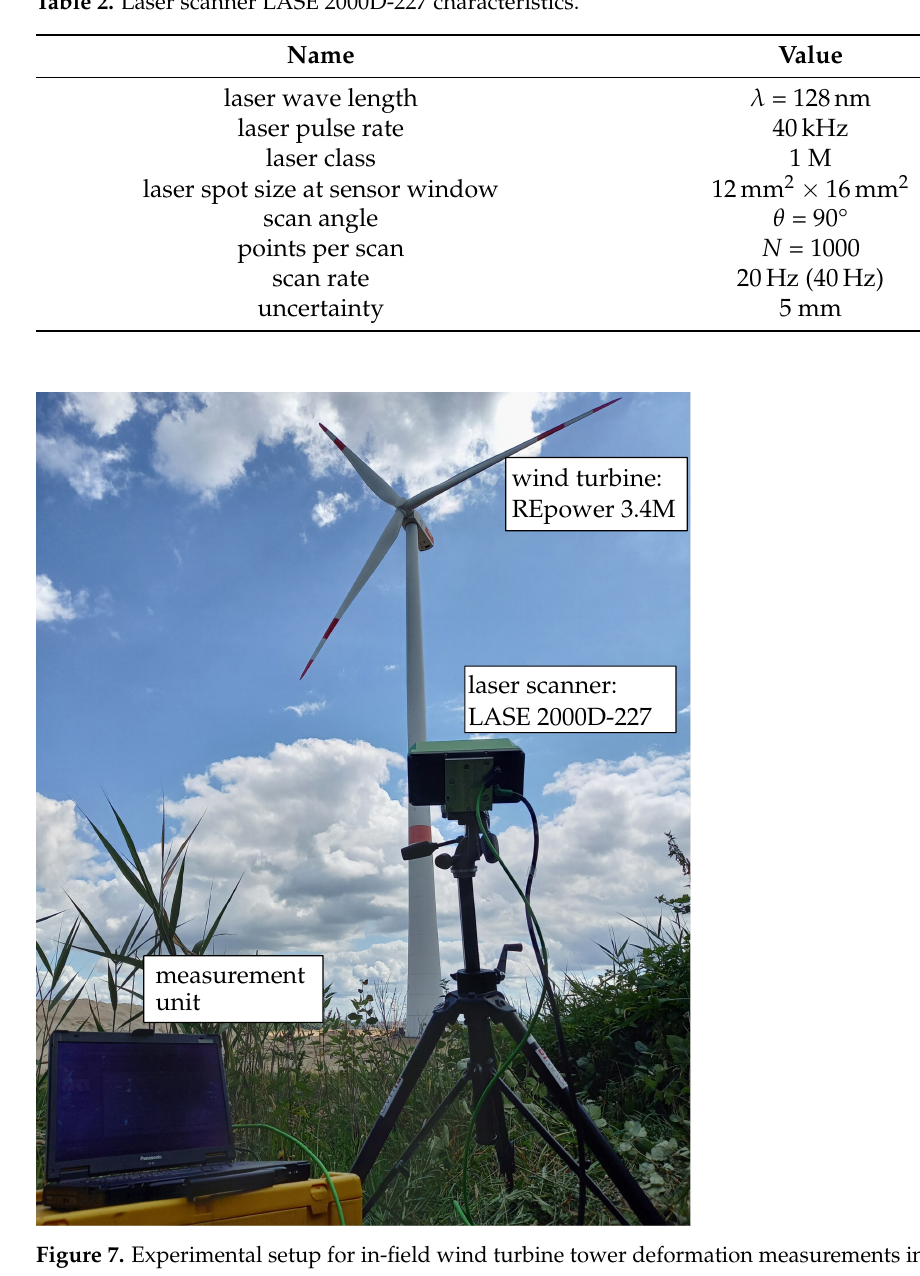
Table 2. Laser scanner LASE 2000D-227 characteristics.